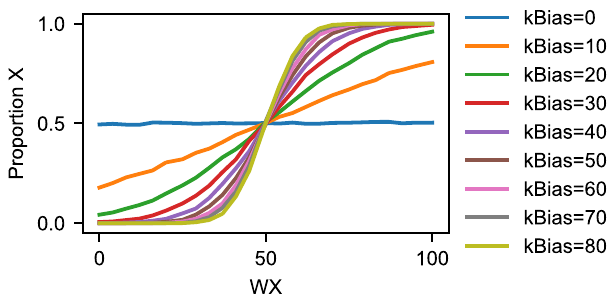
Fig 2. Analysis of decision probabilities as a function of weighting species counts. In each of 10 5 traces, a CRN is initialized with 50 of each state species X and Y , and variable amounts of the weight species WX (plotted on x-axis) and WY , such that WX þ WY ¼ 100 . Each trace is 0.5 time units. After 0.45 time units, 100 molecules of the Stimulus species are added, and the state chosen is recorded, where a state is defined by 90 or more state molecules when sampled at t = 0.475 (halfway between the Stimulus perturbation and the end of the simulation). The proportion of traces that resulted in the X state is shown on the y-axis. The rate kBias is varied, and the common parameters are as follows: kAM = 1, kNoise =